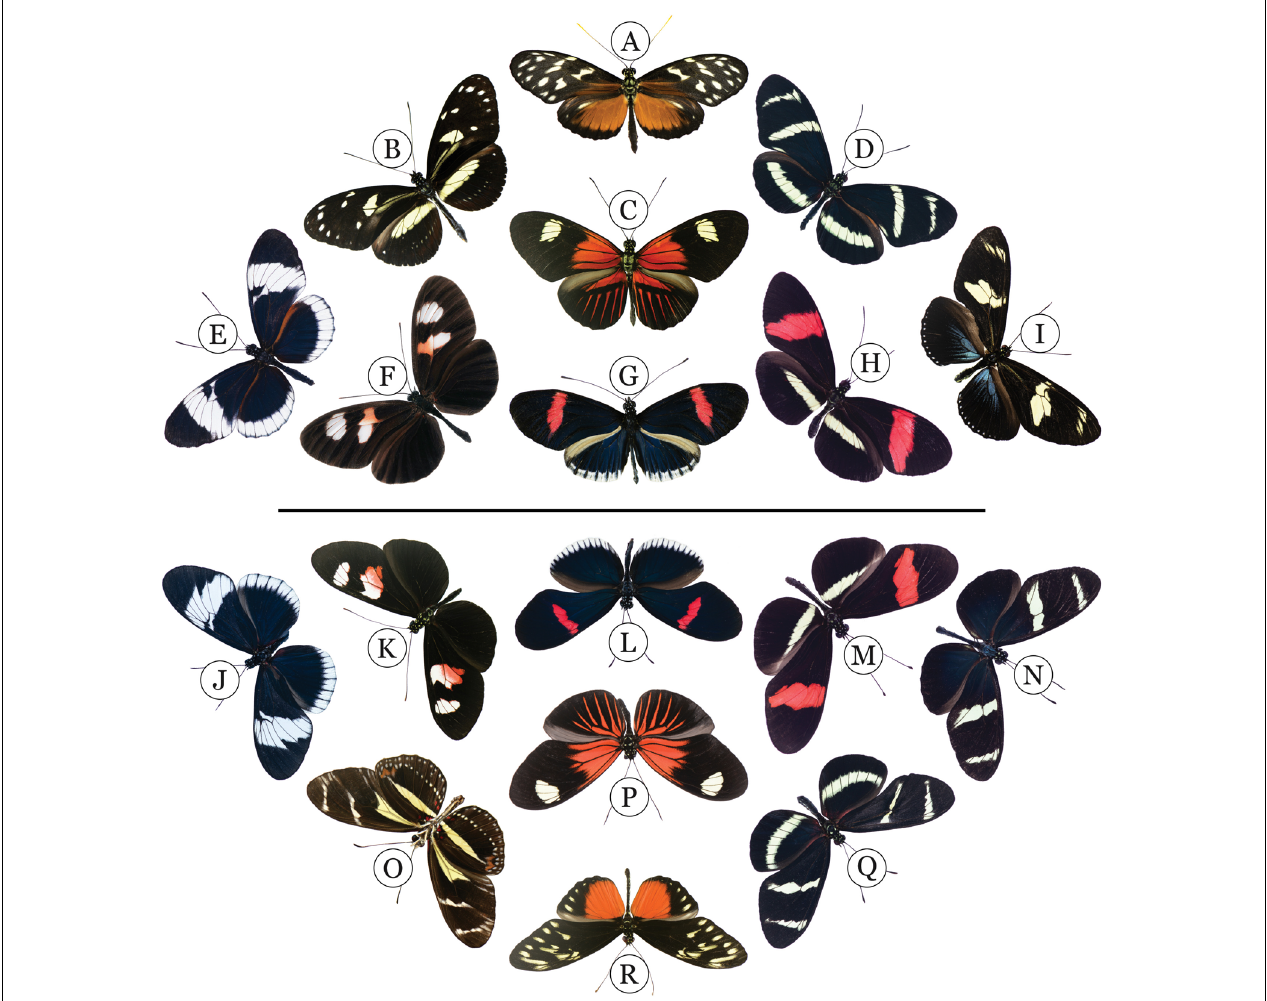
FIGURE 1 | Evolution’s canvas: Wing pattern mimicry among species in the melpomene / cydno / silvaniform clade (MCS) (above line) and the erato / sapho / sara clade (ESS) (below line). The two lineages diverged from each other about 12 MYA (Kozak et al., 2015), yet have recently evolved a complement of identically patterned wings. Species in the MCS clade are: (A) H. hecale zuleika , (B) H. atthis , (C) H. melpomene ecuadorensis , (D) H. pachinus , (E) H. cydno chioneus , (F) H. m. plesseni , (G) H. m. cythera , (H) , H. m. rosina . Species in the ESS clade are: (J) H. sapho sapho , (K) H. erato notabilis , (L) H. e. cyrbia , (M) H. e. demophoon , (N) H. sara sara , (O) H. peruvianus , (P) H. e. etylus , (Q) H. hewitsoni , (R) H. hecalesia formosus . Heliconius doris (I) is from a third clade that falls between the ESS and MCS